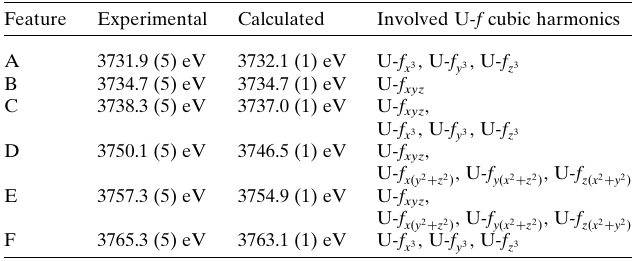
Table 2 Energy position of experimentally observed and calculated U M 4 -edge HERFD-XANES post-edge spectral features; the U- f cubic harmonics mainly contributing to these features are also indicated. Feature